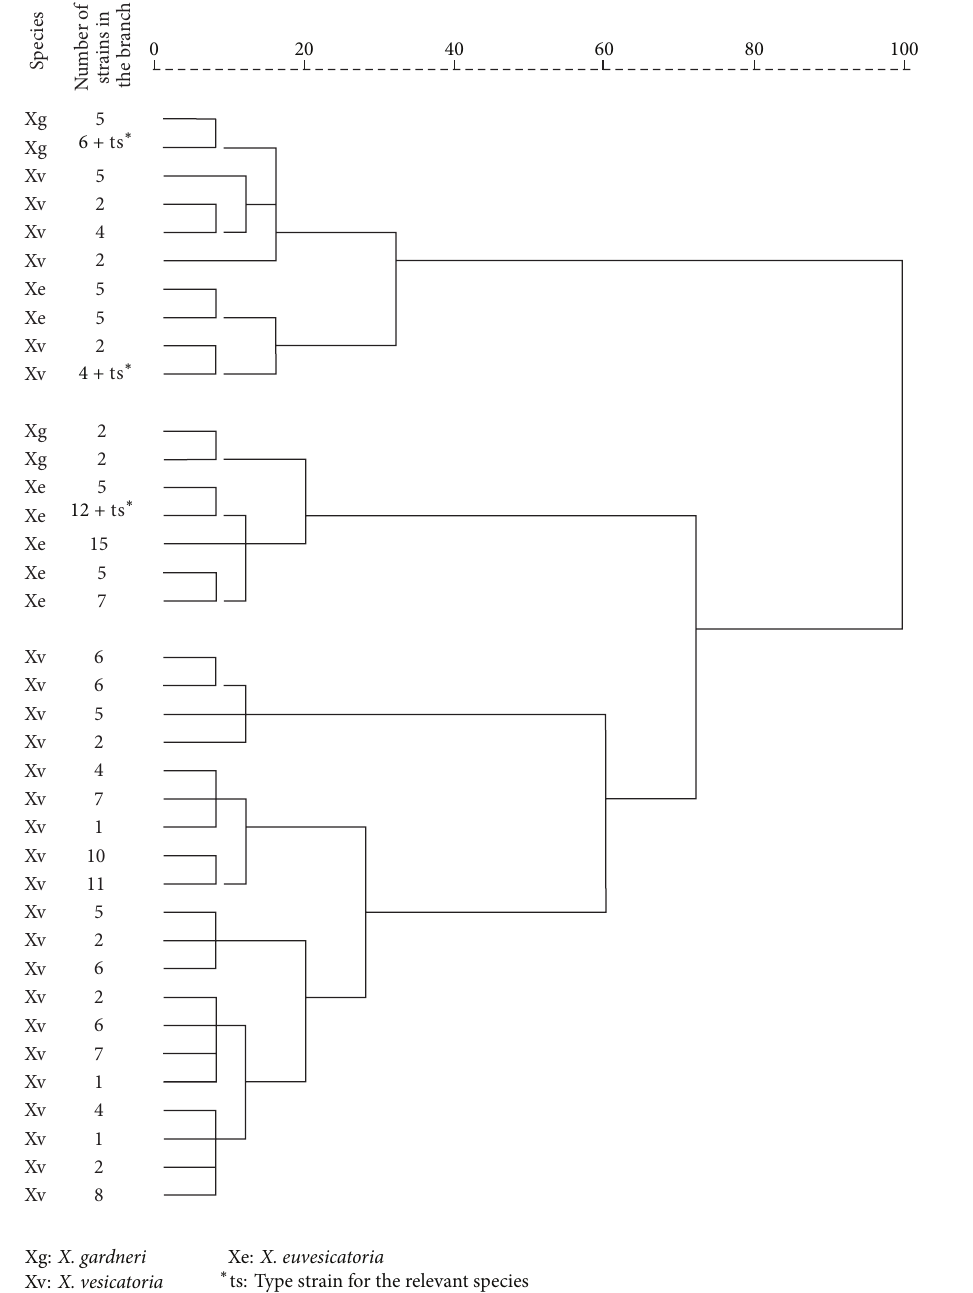
Figure 1: Cluster analysis of the Bulgarian strains of genus Xanthomonas isolated from pepper, tomato, and weeds based on their Biolog metabolic